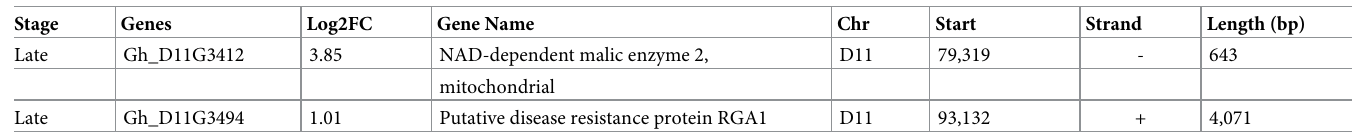
PLOS ONE | https://doi.org/10.1371/journal.pone.0221328 September 10,